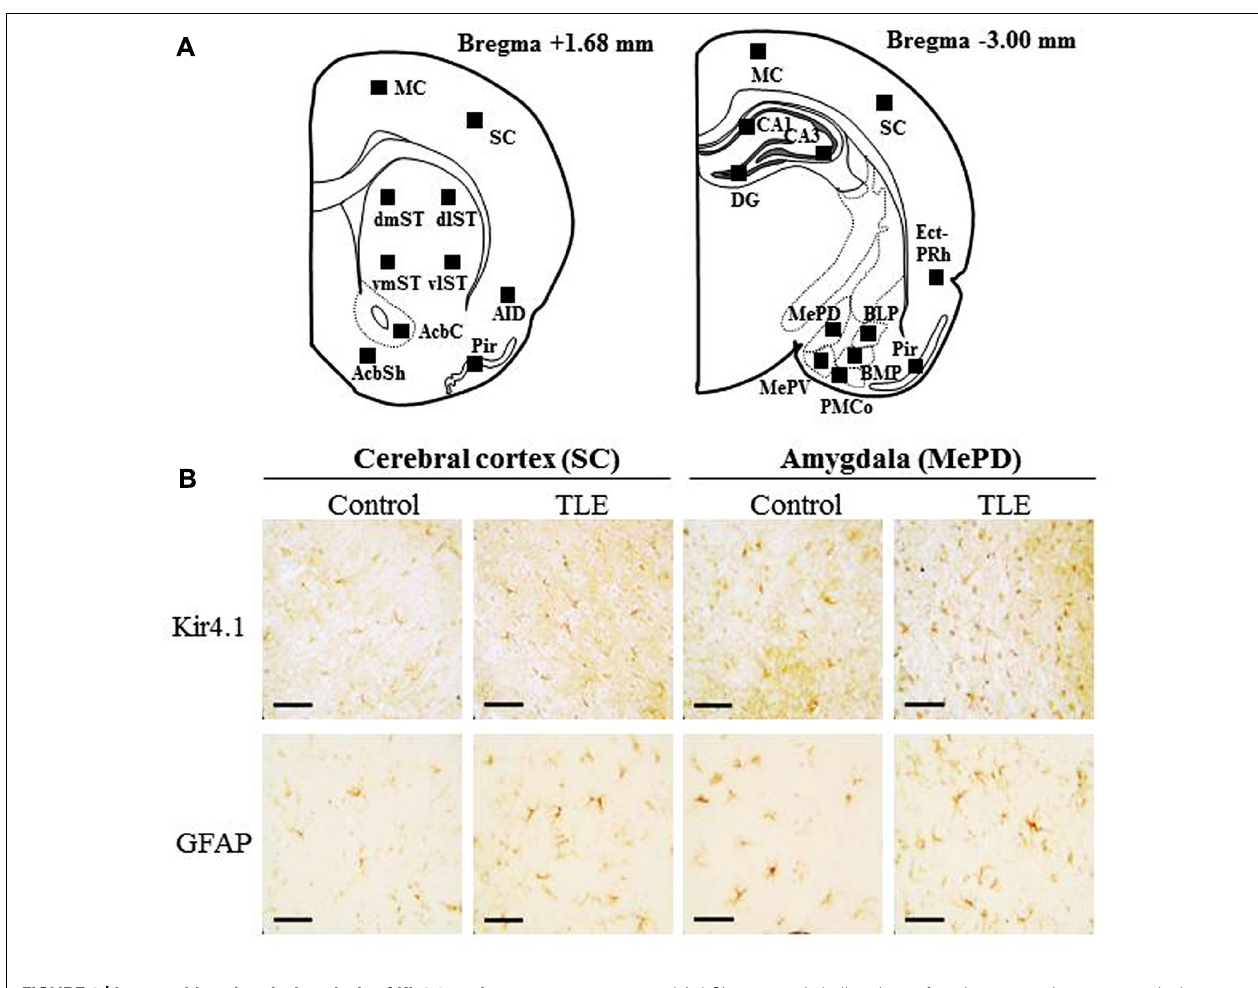
FIGURE 2 | Immunohistochemical analysis of Kir4.1- and GFAP-immunoreactivity (IR)-positive cells in pilocarpine-inducedTLE rats. (A) Schematic illustrations of the brain sections selected for quantitative analysis of Kir4.1- and GFAP-IR-positive cells. Squares in each section indicate the area analyzed for counting of Kir4.1- and GFAP-IR-positive cells.The distance from the Bregma is shown on the bottom of each section. MC, motor cortex; SC, sensory cortex; AID, agranular insular cortex; Pir, piriform cortex; dmST, vmST, dlST and vlST, dorsomedial, ventromedial, dorsolateral, and ventrolateral striatum, respectively; AcbC